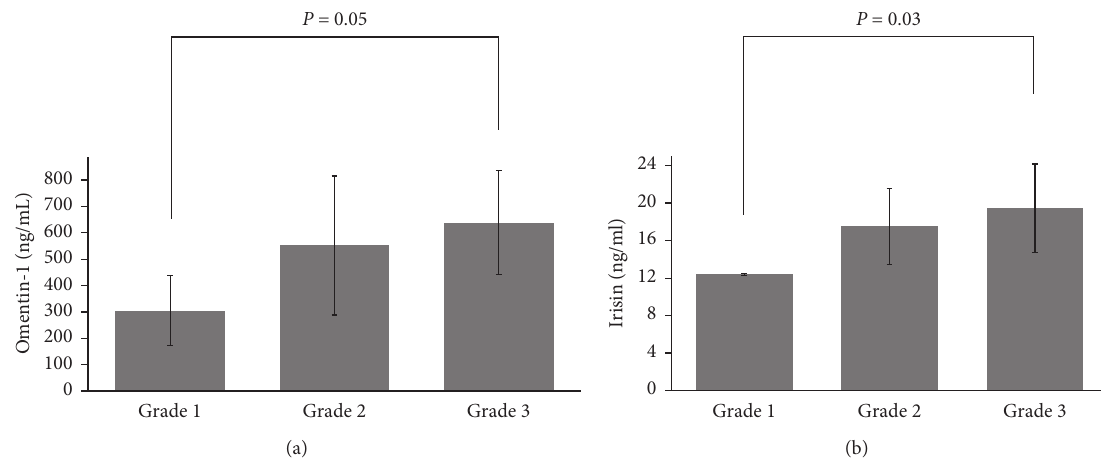
Figure 2: Omentin-1 (a) and irisin (b) serum levels according to the Elston-Ellis modification of the Scarff-Bloom-Richardson grading system. Data are presented as mean ± SD. Analysis of variance (ANOVA) and post hoc comparisons were employed. Logarithmically transformed variables were used for both